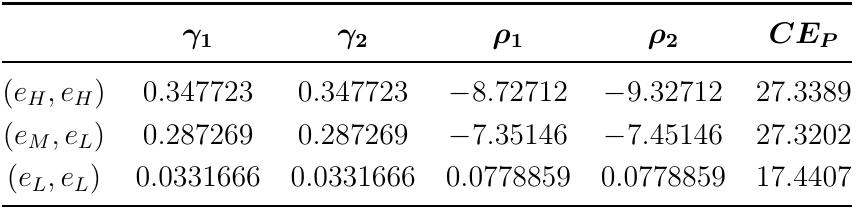
Table A1. Optimal incentive contracts of Example 5.